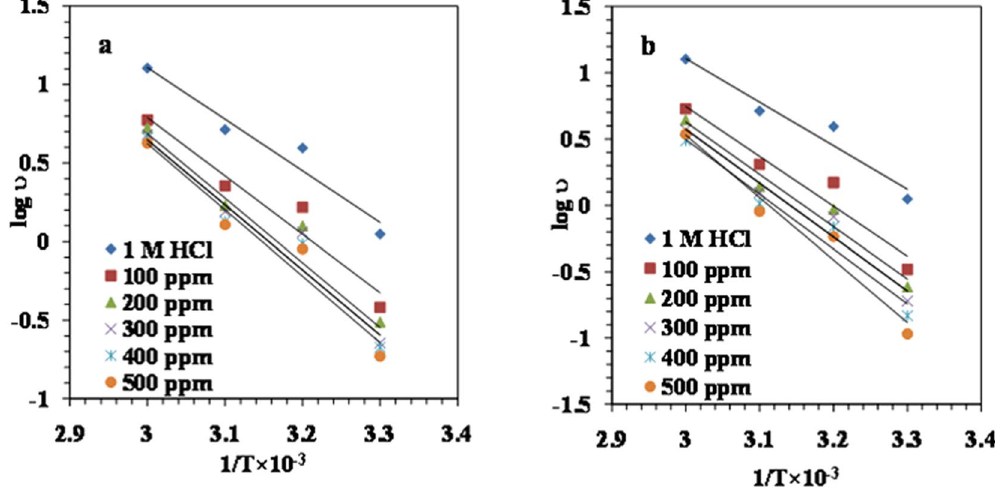
Figure 10. Arrhenius plots for MS in 1M HCl in the absence and presence of different concentrations of ( a ) LPr and ( b ) LPr + 10 ppm NaBenz.